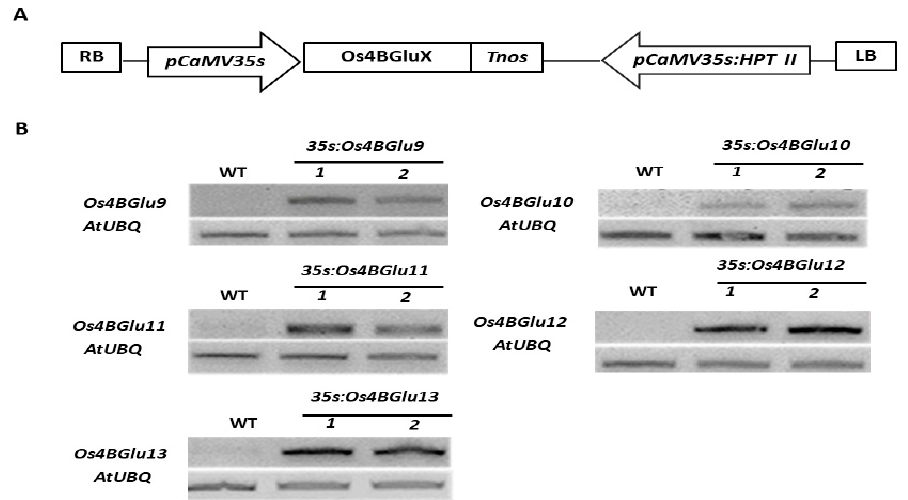
Figure 3. Heterologous expression of rice GH1 Cluster At/Os7 genes in Arabidopsis. ( A ) Schematic diagram of expression vectors in which Os4BGluX represents the cDNA for Os4BGlu9, Os4BGlu10, Os4BGlu11, Os4BGlu12 or Os4BGlu13. Cloned full-length cDNAs including partial sequence of 5 ′ and 3 ′ untranslated regions were inserted under the control of the pCaMV35S promoter. LB and RB, left and right borders of T-DNA; HPT II, hygromycin phosphotransferase II gene. ( B ) RT-PCR analysis of β -glucosidases gene expression in Arabidopsis thaliana wild type ecotype Col-0 to two independent lines of transgenic Arabidopsis expressing rice β -glucosidases Os4BGlu9, Os4BGlu10, Os4BGlu11, Os4BGlu12 and Os4BGlu13, respectively.